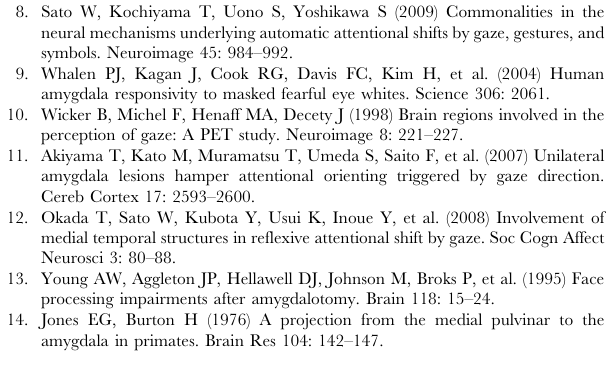
Figure S1 Amygdala activity under the second stimulus presen- tation condition. a) Adjusted time–frequency maps of the amygdala for averted eyes, straight eyes, averted mosaics, and straight mosaics. The results for both hemispheres are combined. Blue crosses indicate the locations of activation foci for the main effects of stimulus type, contrasting the effects of eyes versus mosaics (285 ms, 40 Hz). b) A statistical parametric map that exhibited evident activation for the main effects of stimulus type. A blue cross indicates the location of activation focus. c) Mean (with SE) effect size at the peak activation focus for the main effects of stimulus type. The results of both hemispheres are combined. d) Statistical parametric maps that exhibited higher activation for eyes than for mosaics in the analyses after covarying out the gamma-band horizontal and vertical EOGs. A blue cross indicates the location of activation focus. Figure S2 Adjusted time–frequency maps of the white matter adjacent to the amygdala in response to averted eyes, straight eyes, averted mosaics, and straight mosaics under the first (a) and second (b) stimulus-presentation conditions. The results for both hemispheres are